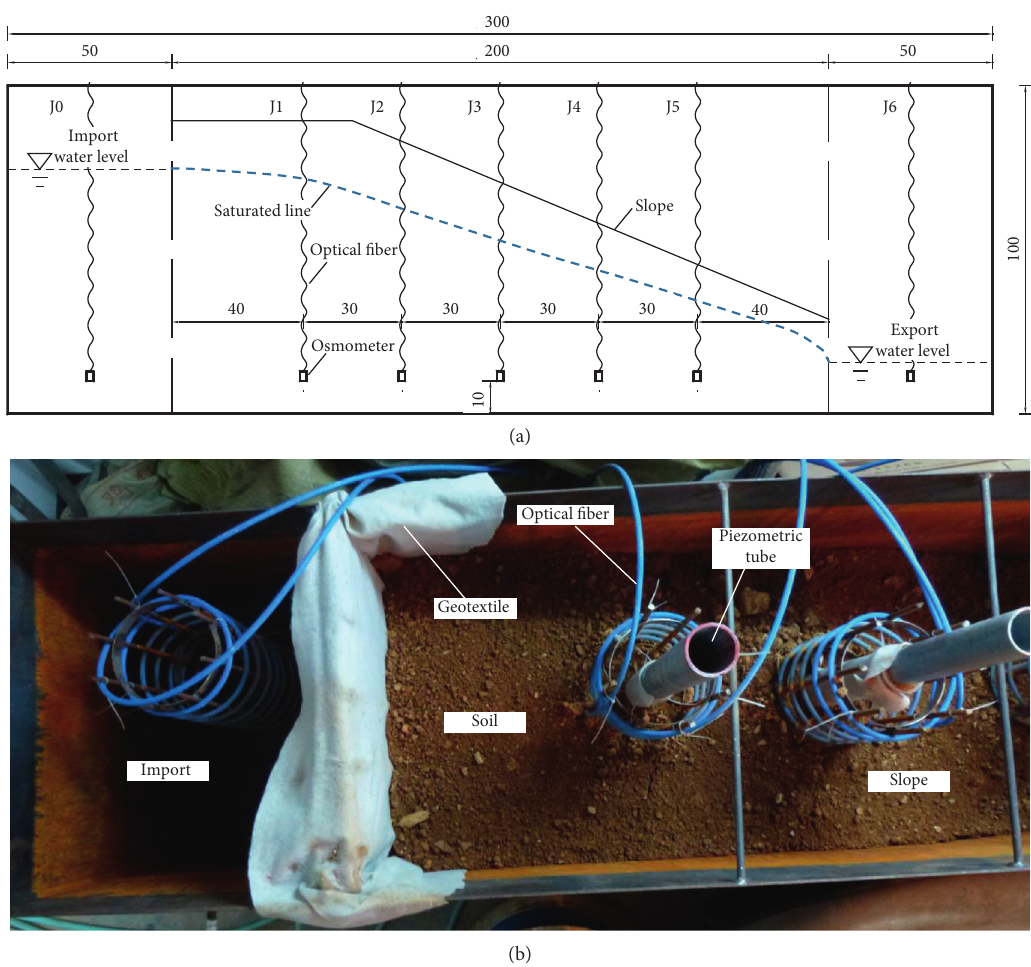
Figure 3: Two-dimensional rectangular model diagram and measurement process (unit: cm).